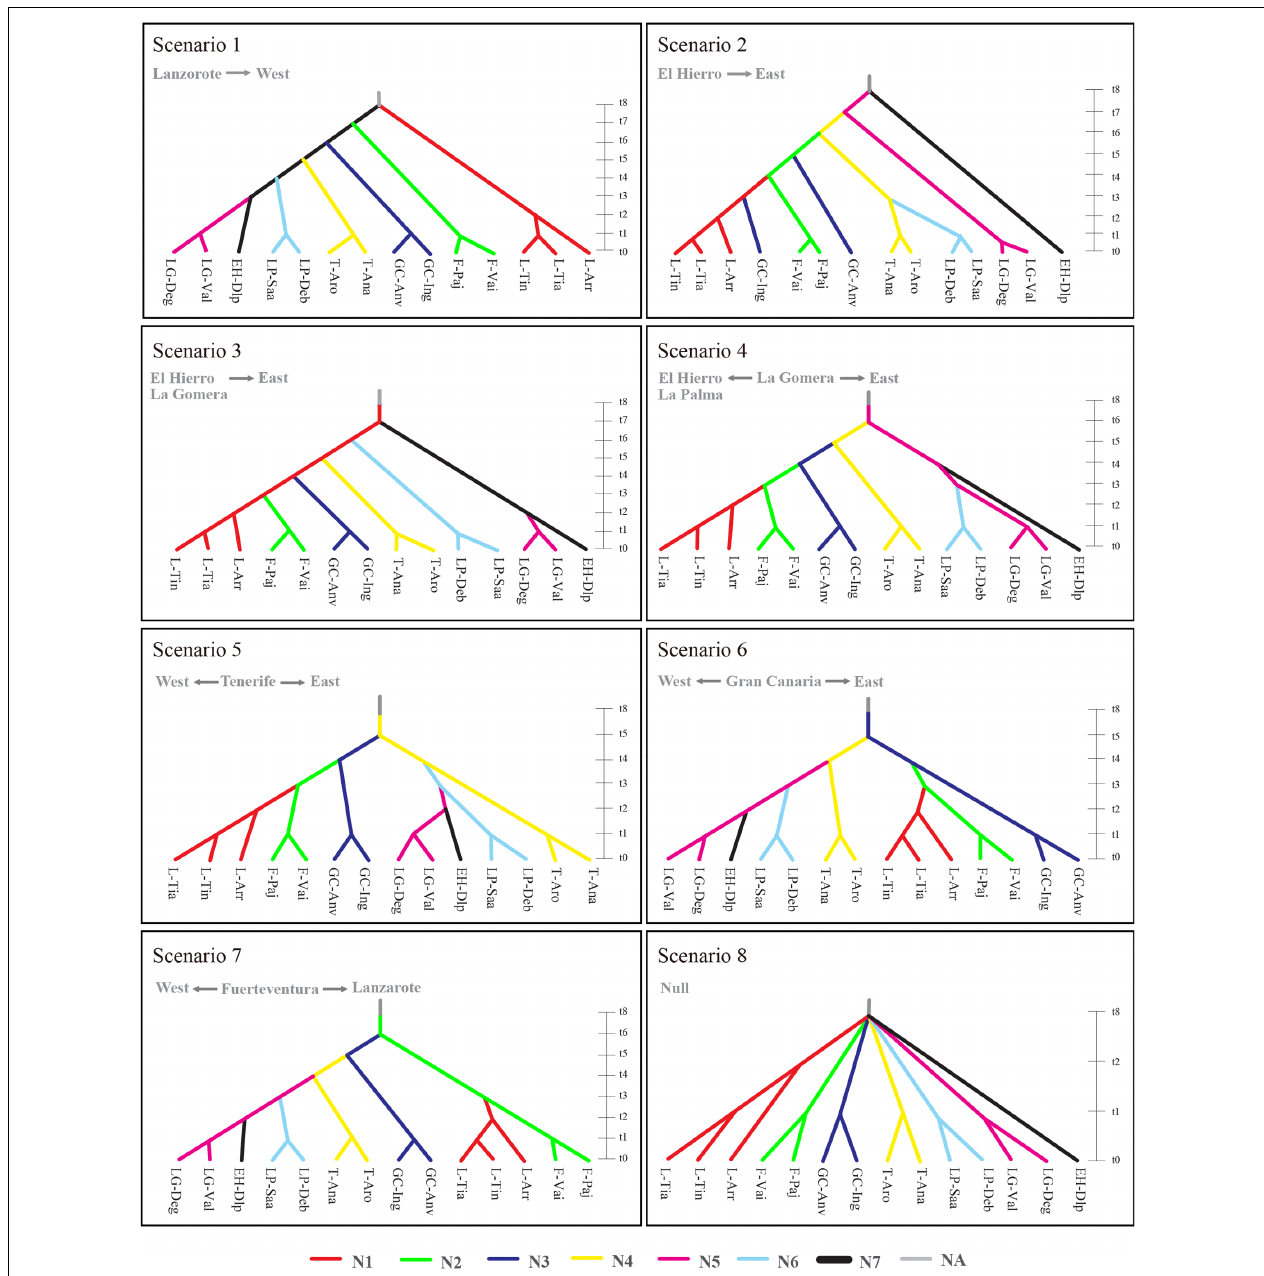
FIGURE 1 | Eight evolutionary scenarios with 14 sampled populations were tested in this study, placing each island has the hypothetical ancestral population with exception of La Palma. Scenario 1: Lanzarote to west; scenario 2: El Hierro to east; scenario 3: El Hierro-La Gomera to east; scenario 4: La Gomera as oldest population; scenario 5: Tenerife as oldest population; scenario 6: Gran Canaria as oldest population; scenario 7 Fuerteventura as oldest population; finally, scenario 8 is a null scenario where all of populations split up outside of archipelago. Time scale was measured in generations. Effective population size is shown by each island (N1, Lanzarote; N2, Fuerteventura; N3, Garn Canaria; N4, Tenerife; N5, La Gomera; N6, La Palma; N7, El Hierro; NA, ancestral non-sampled population). Population codes are same as that in Table 1